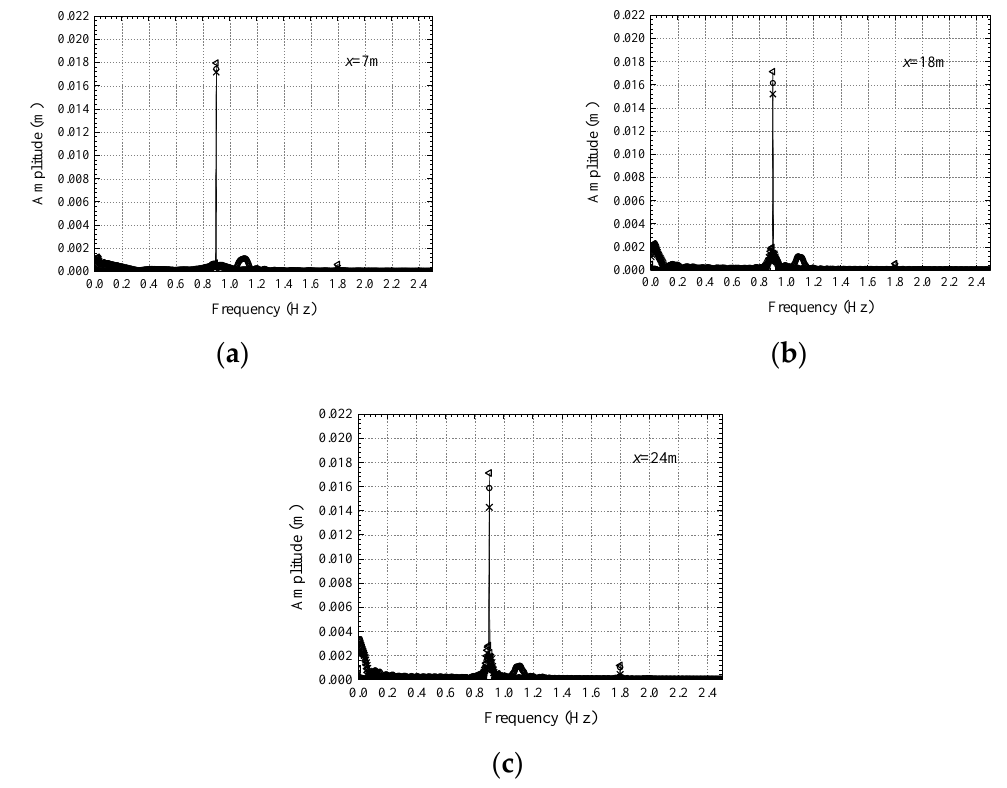
Figure 16. Distribution of environmental wave heights along the downstream ( ▼ ), no-current ( ● ), and counter-current ( ■ ) of MIKE 21 BW model.